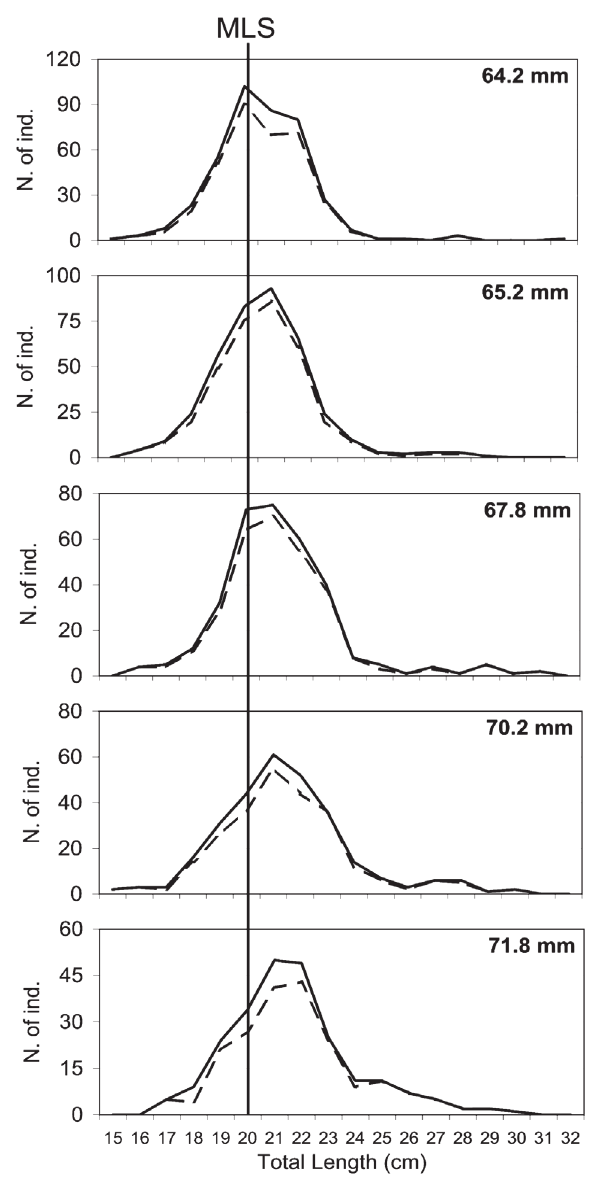
Fig . 3. – Size-frequency distributions of the soles caught with gill nets of different mesh sizes computed with pooled data from all sets and from the sets selected for the REML analysis. MLS = Minimum Landing Size (20 cm TL). Broken lines = all sets; continuous lines = sets used in REML